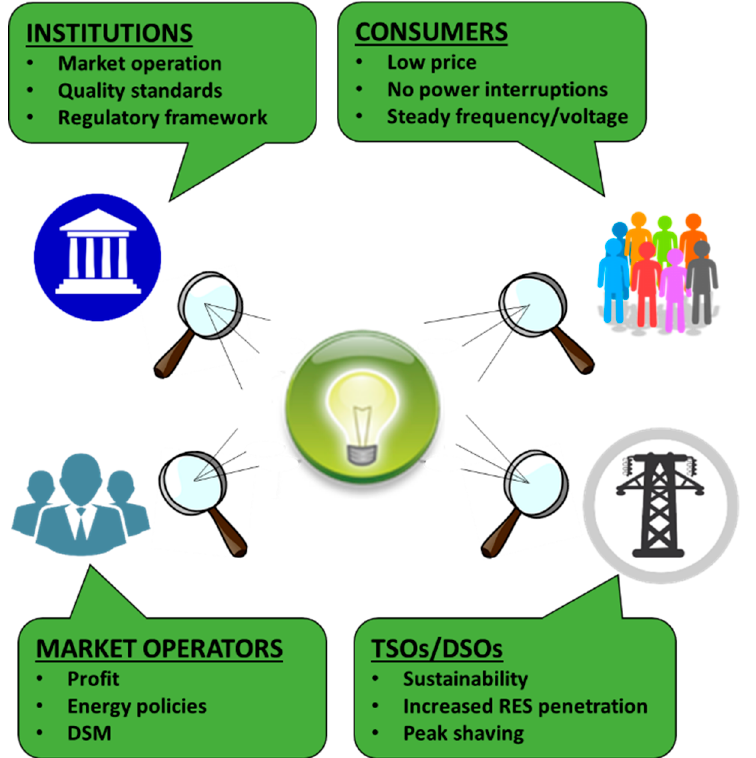
Figure 1. The four main categories of stakeholders for Smart Island studies, followed by their main concerns. main